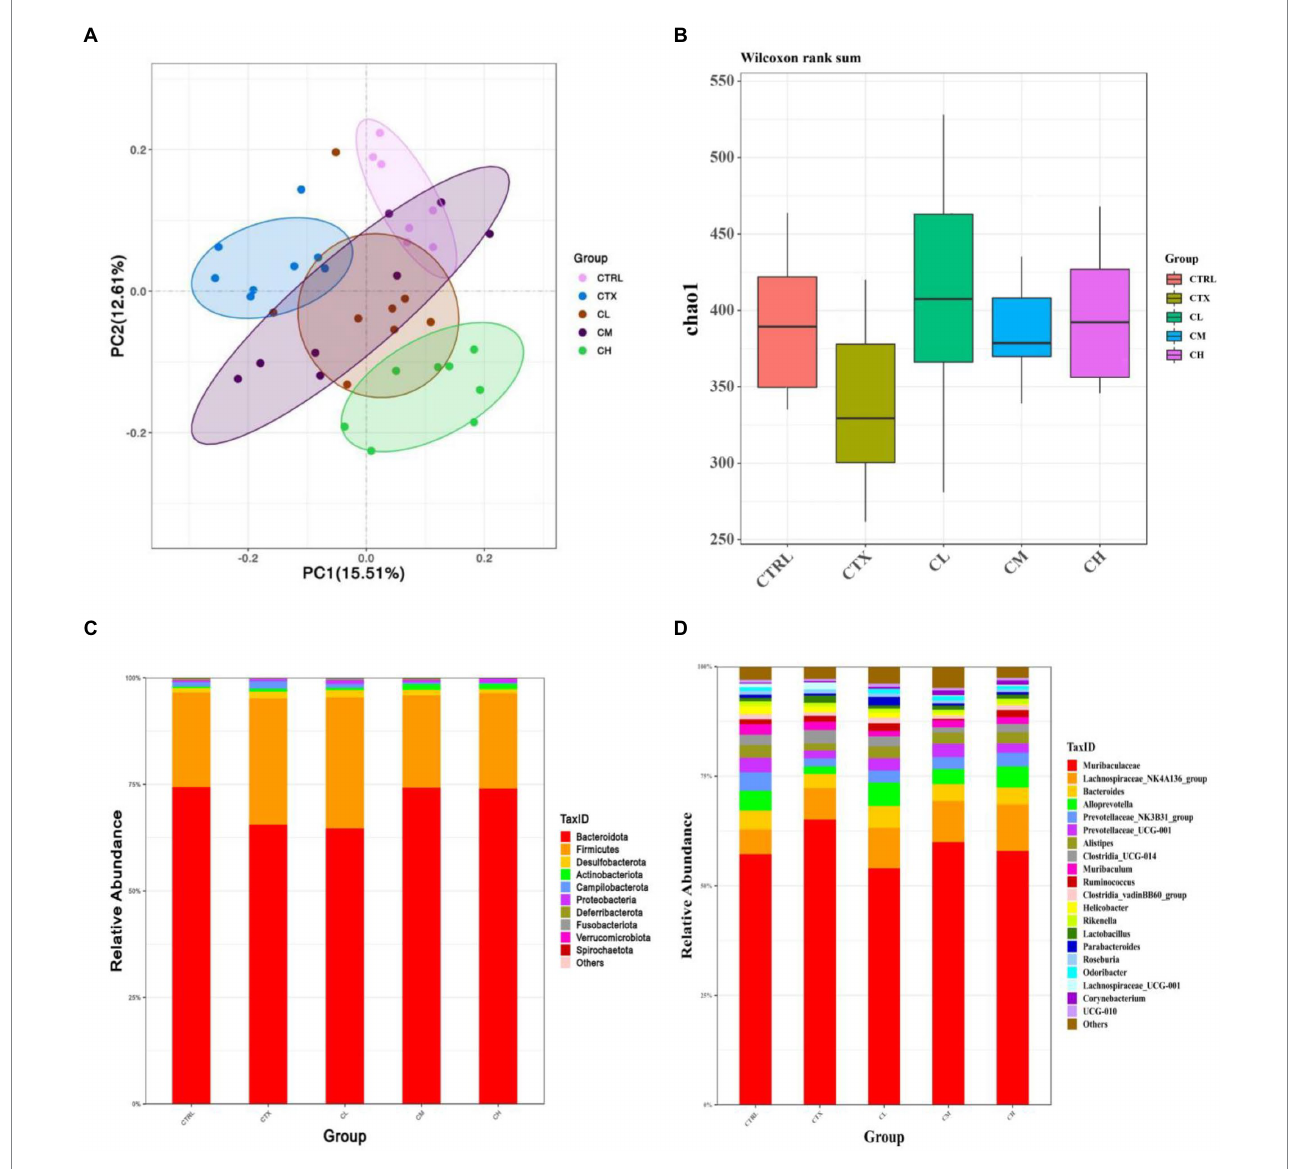
FIGURE 6 Complex probiotics treatments attenuated gut microbiota dysbiosis in CTX-induced immunosuppression mice. ( n = 8 for each group). (A) Chao1 indexes. (B) Binary Jaccard-based PCoA. (C) Bacterial taxonomic profiling at the phylum level. (D) Bacterial taxonomic profiling at the genus level. CTRL, normal control group; CTX, model control group; LEV, levamisole hydrochloride; CL, low-dose complex probiotics; CM, medium-dose complex probiotics; CH, high-dose complex